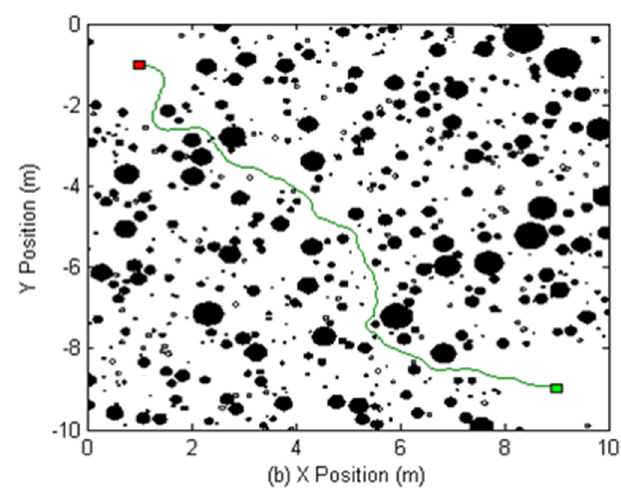
Figure 1. Artificial potential field path through a rockfield (repellors) towards a goal (attractor)—this rockfield models the Mars Viking 2 landing site but appropriate constraints may be crater slopes, slippery locations due to loose soil, etc., which impose constraints on straight line paths between start and goal locations.